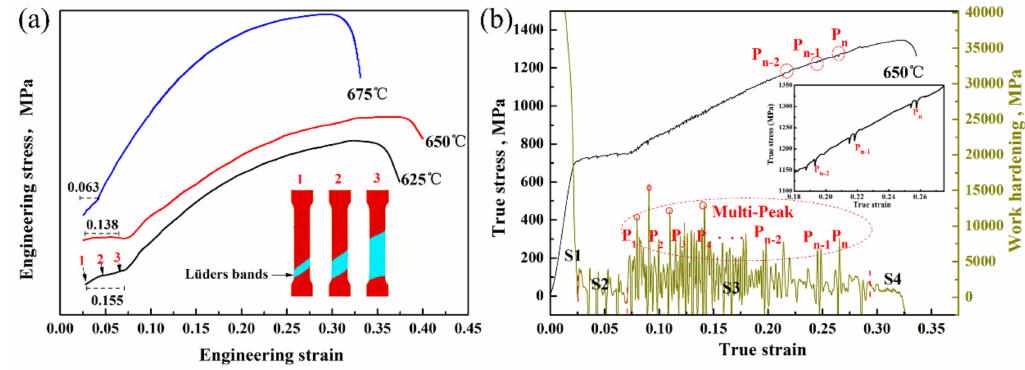
Figure 10. Variation of ( a ) length of Lüders strain at different temperatures, ( b ) Work-hardening rate and true strain–stress plot of sample heat treated at 650 ◦ C.